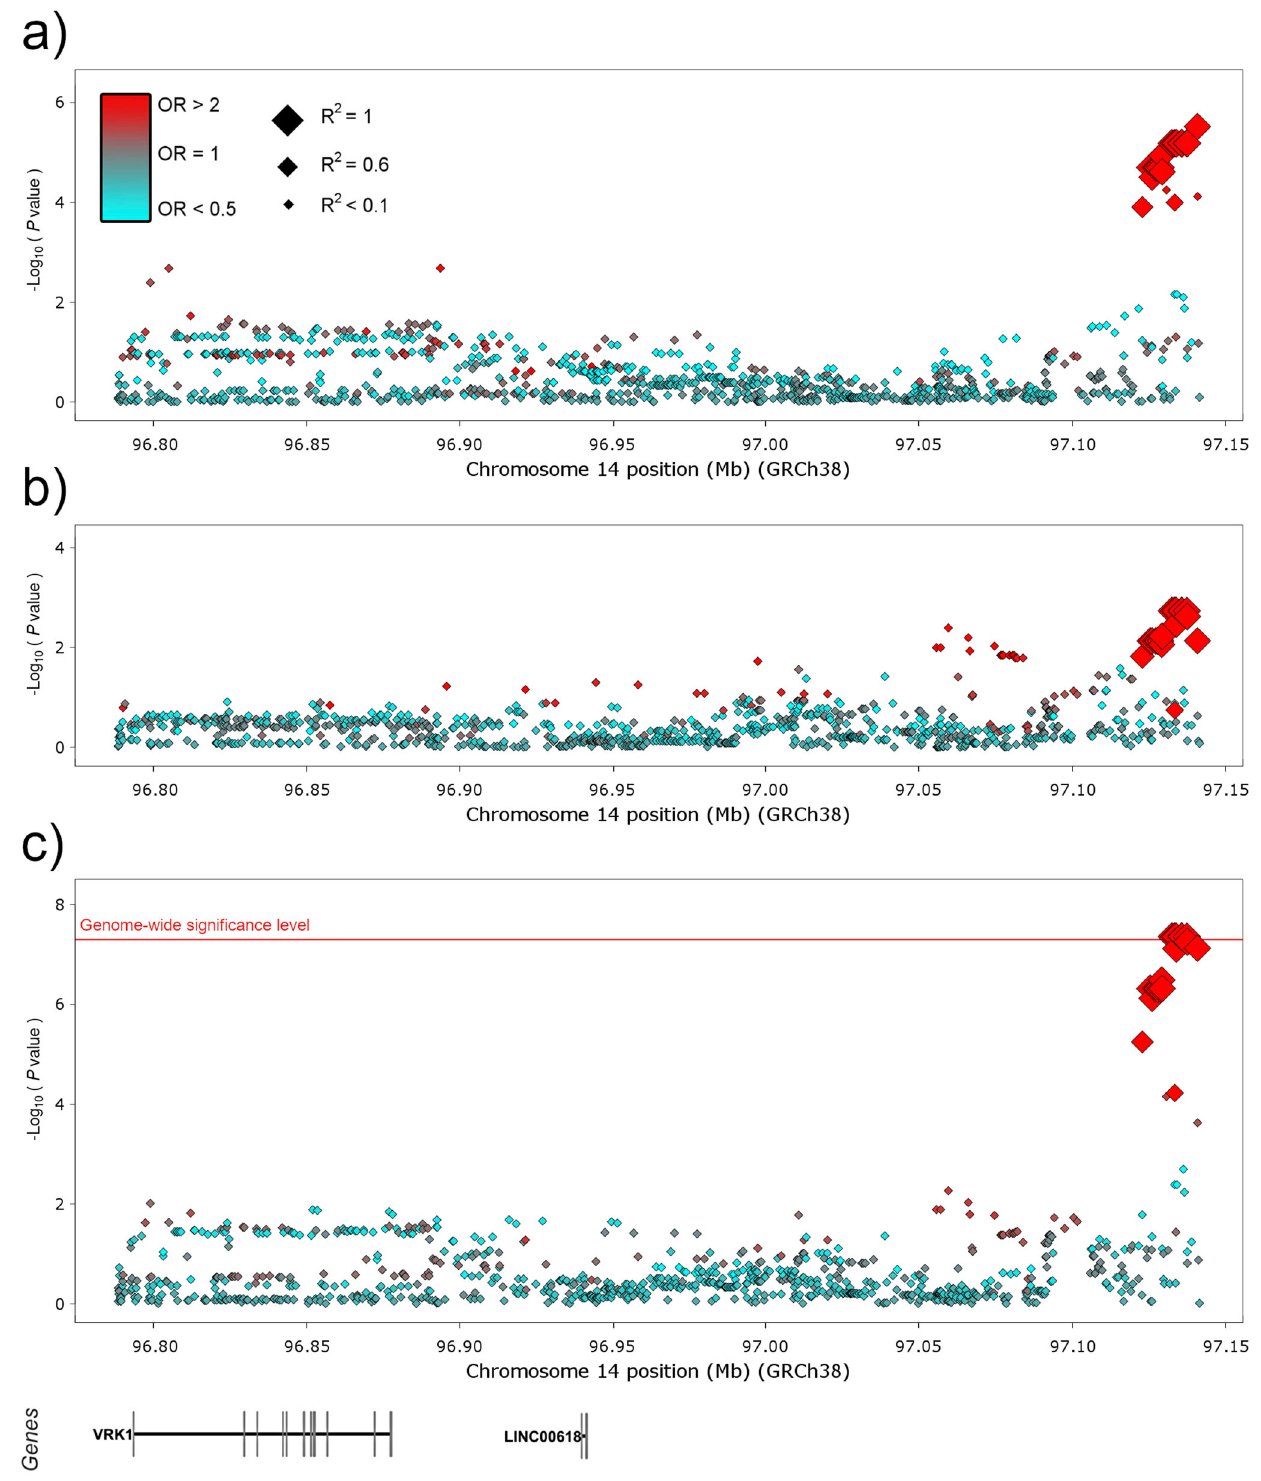
Fig. 3 Manhattan plot representation of the logistic regression test for the VKR1 region accordingly with Sertoli cell-only phenotype. Data for the Iberian discovery cohort ( a ), the German replication cohort ( b ), and the combined cohort ( c ) are shown. The − log10 of the P -values from the logistic regression tests and the inverse variance method are plotted against their physical chromosomal position. A red/blue colour gradient was used to represent the effect size of each analysed variant (red for risk and blue for protection). The red line represents the genome-wide level of signi fi cance ( P < 5E −